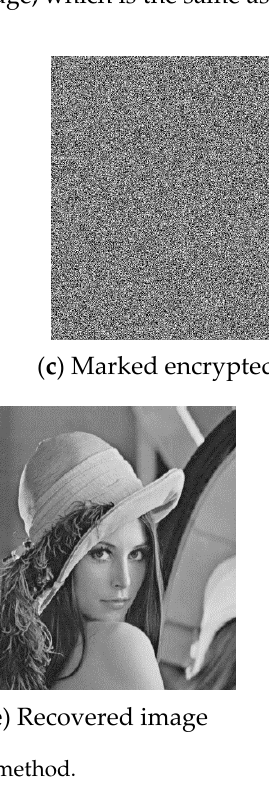
Table 2. Comparison of embedding rates for the eight test images (second). Images